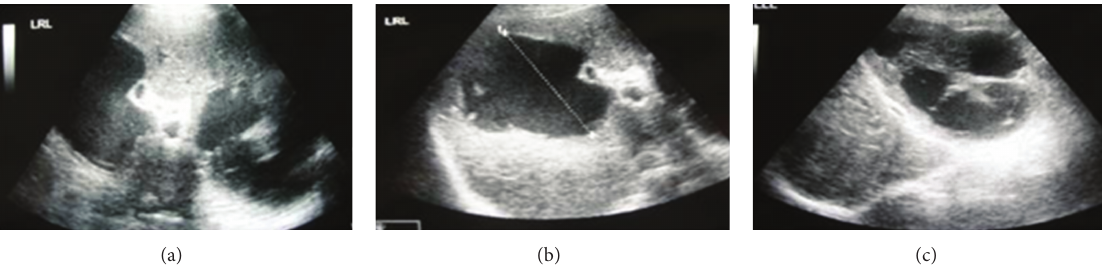
F 1: Abdominal ultrasound demonstrating cystic lesions in the right lobe of the liver that also involves almost the entire le liver lobe.